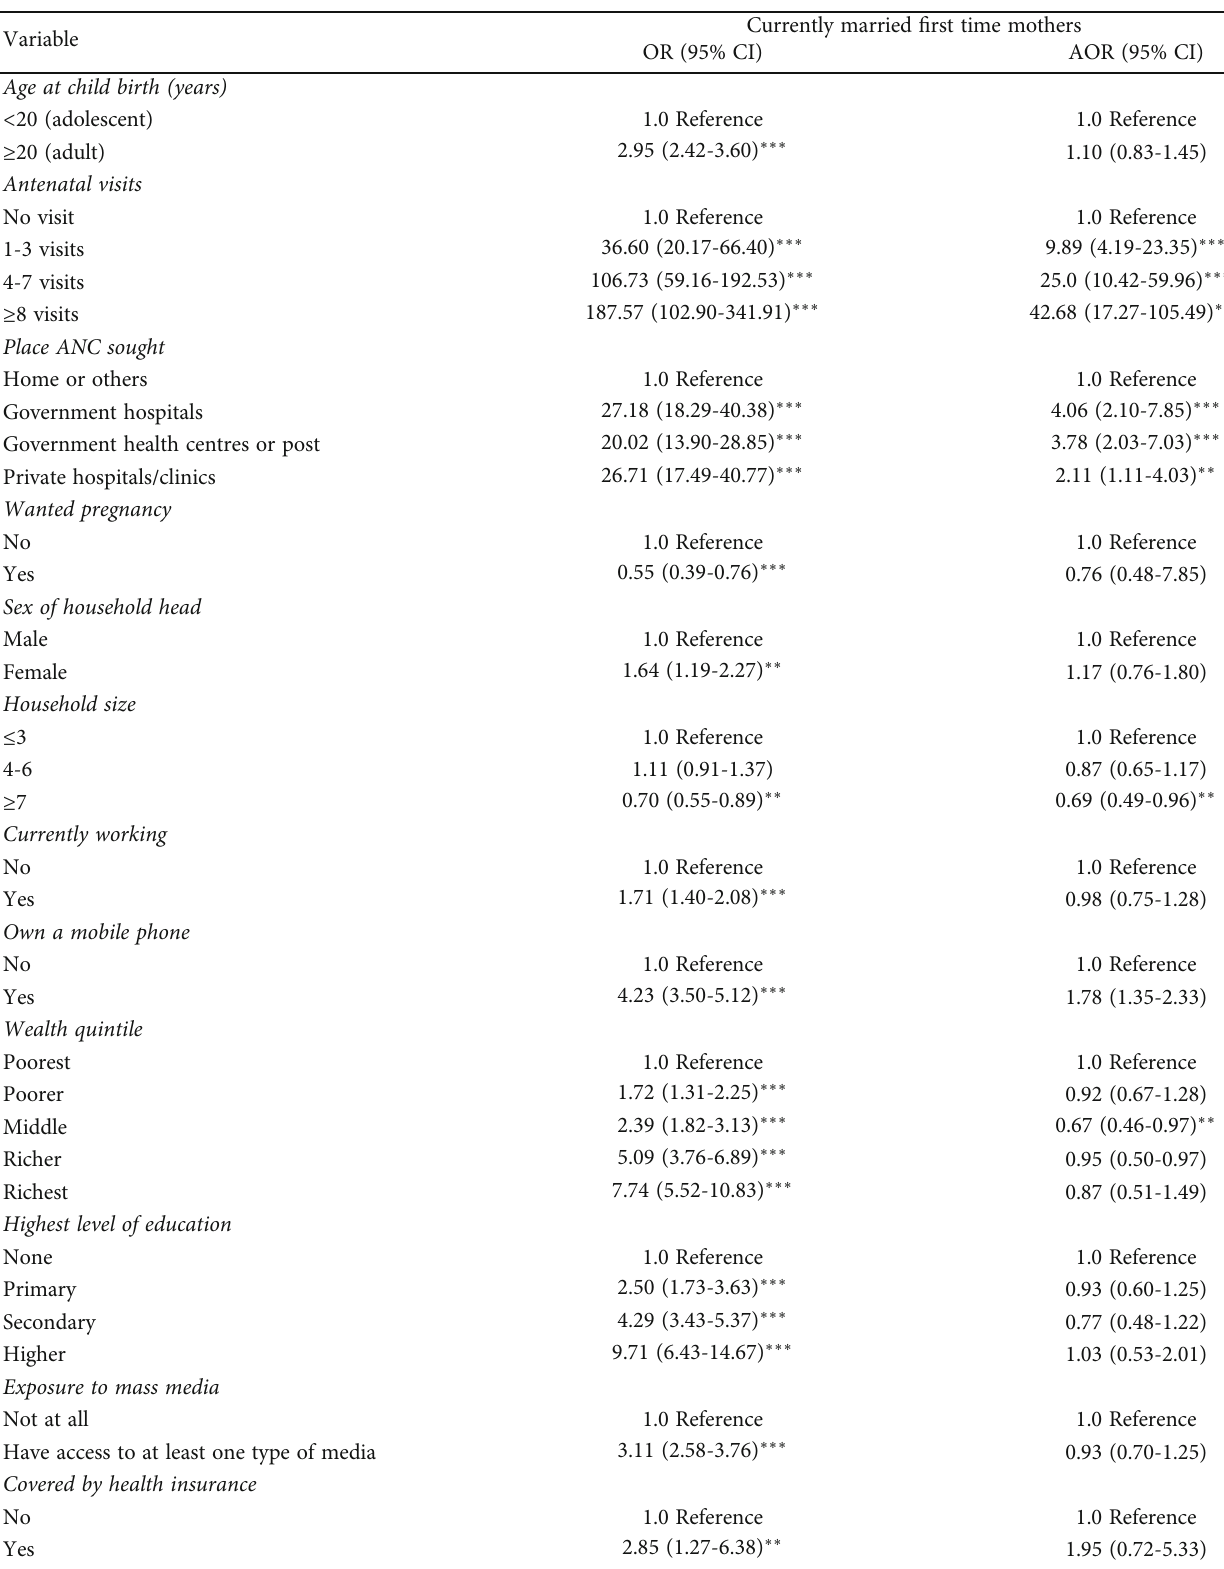
Table 4: Crude and adjusted ordinal logistic regression of currently married fi rst-time mothers who took at least two doses of